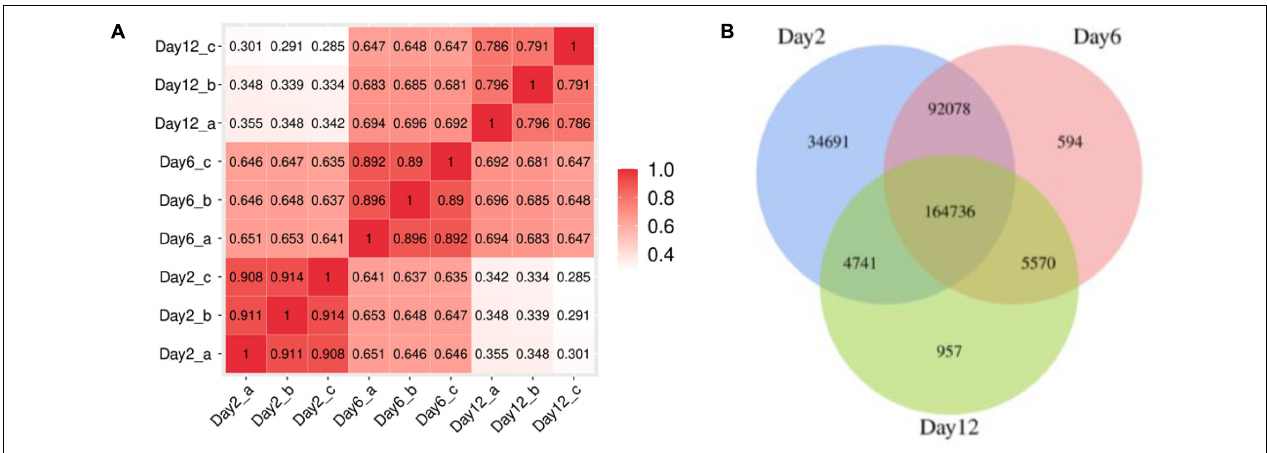
FIGURE 3 | (A) Correlation analysis of the number of predicted gene among the samples; (B) Venn diagram of the distribution of unigenes in fermentation broth